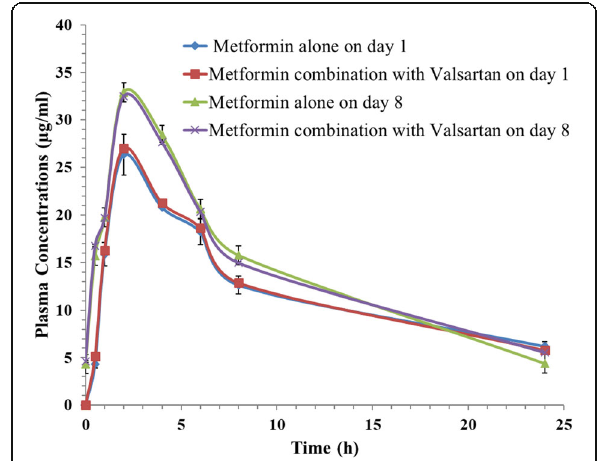
Fig. 5 Drug-drug interaction profile of metformin and valsartan (n = 6). Mean plasma concentrations ( μ g.ml − 1